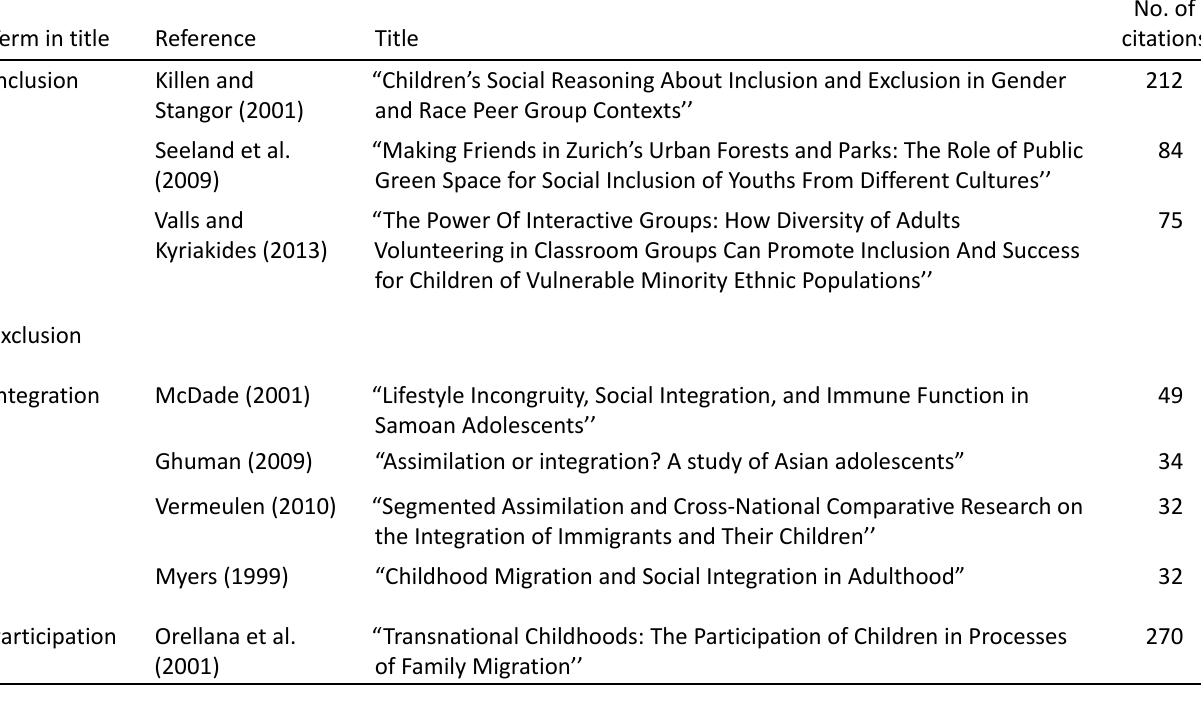
Table 2. (Cont.) Overview of articles addressing children with immigrant backgrounds (sample